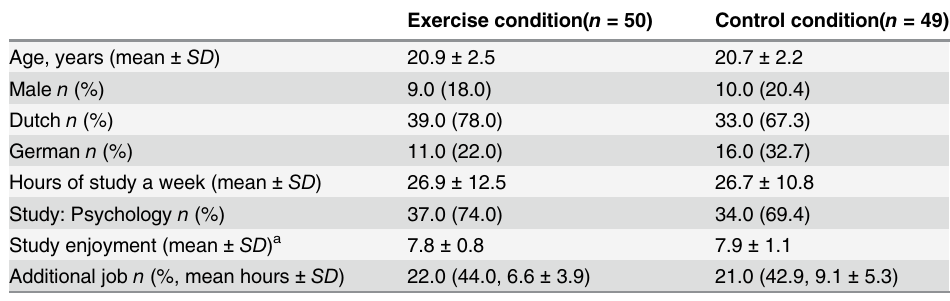
Table 1. Background characteristics at study